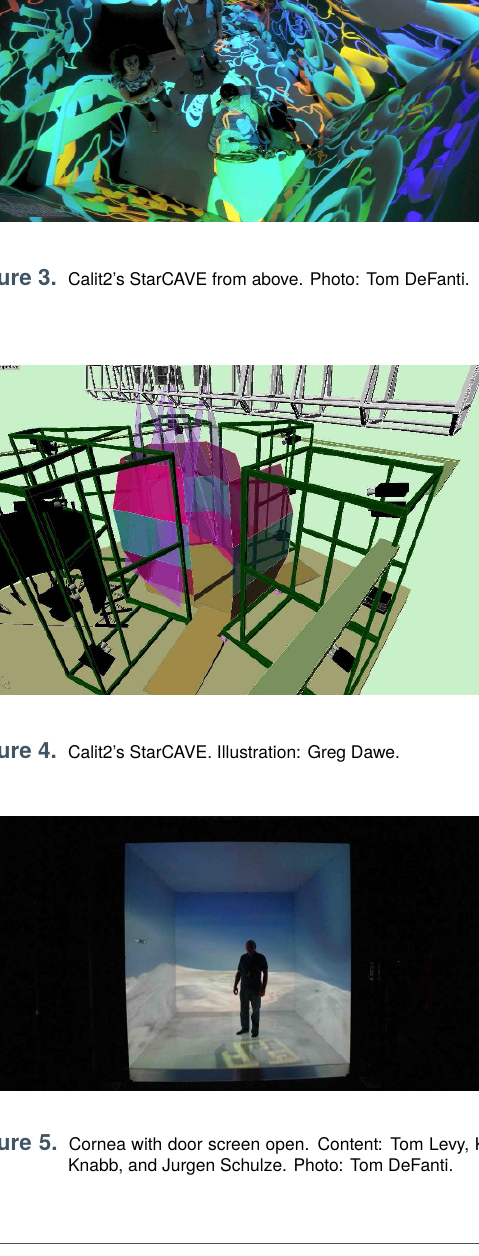
is lessened by the larger than 90 o angle between screens at the corner/corner and corner/floor intersections in this pentagonal cross-section, tilted-screen CAVE. Tilting the top and bottom screens also helps make the illumination to the screens more uniform appearing because the pro- jectors are closer to the optimal on-axis position to the viewer than if they the wall panels were strictly vertical.